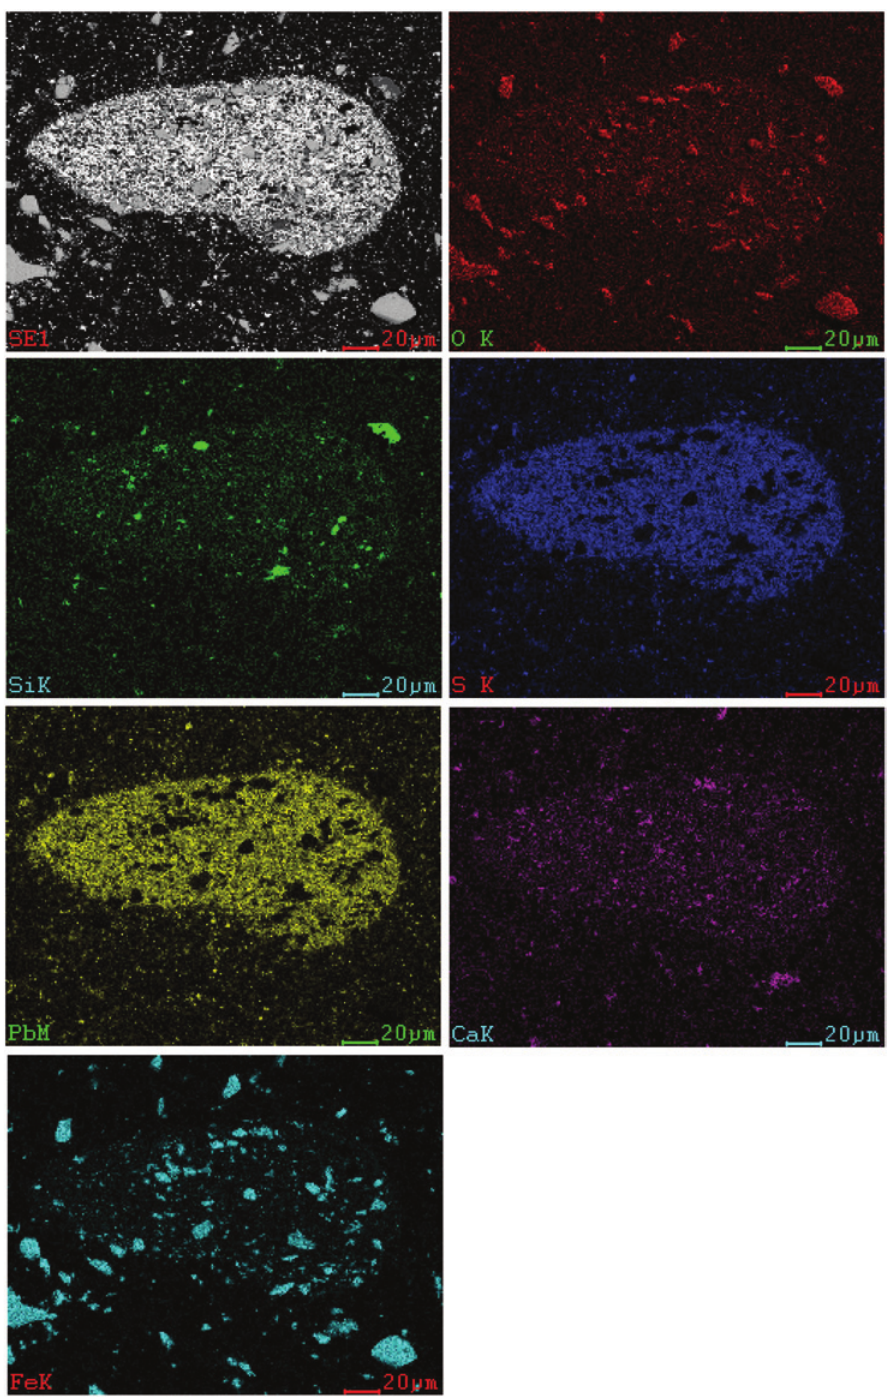
Figure 12: SE image of WLR-SD leached residues and along with the corresponding O, Si, S, Pb, Ca, and Fe